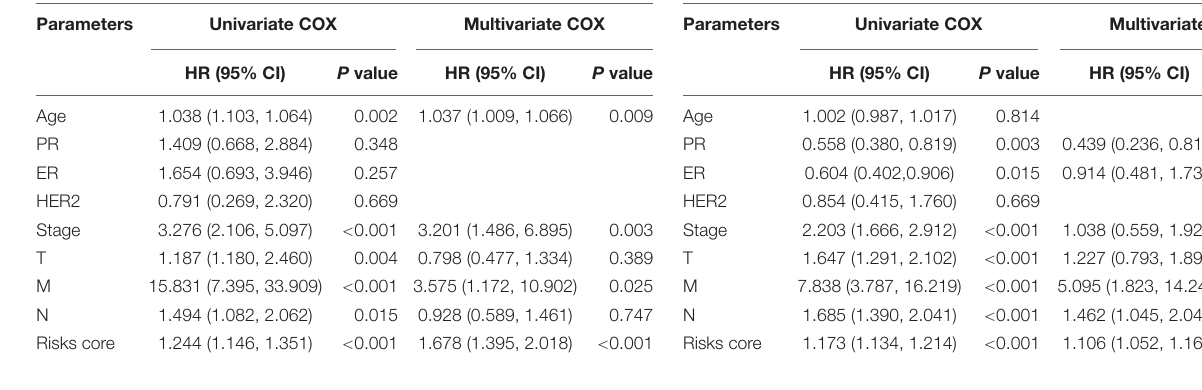
of RNA polymerase II transcription ( Figure 9B ). Based on